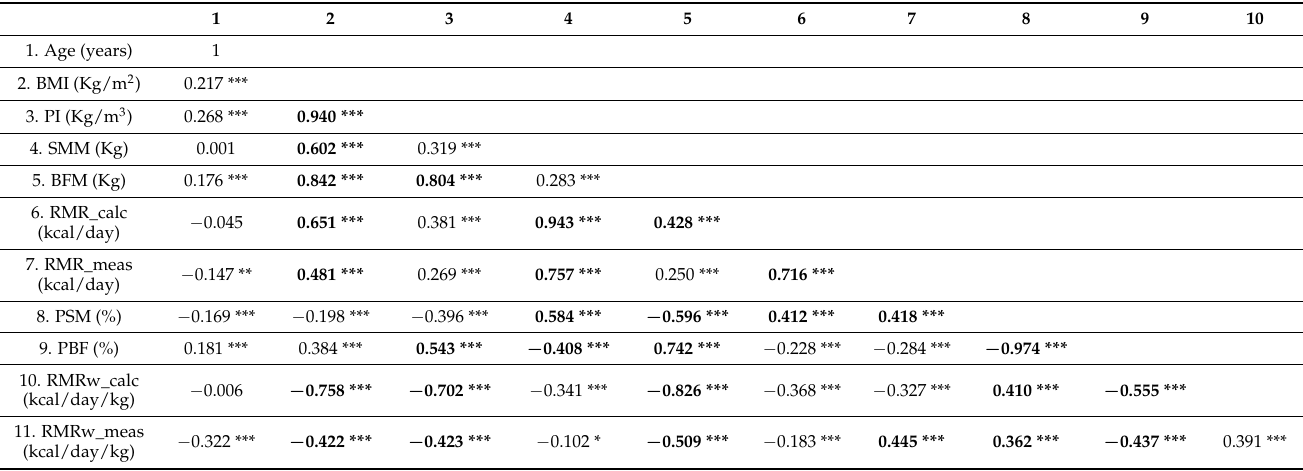
Table 2. Correlation coefficient between unstandardized and standardized physical